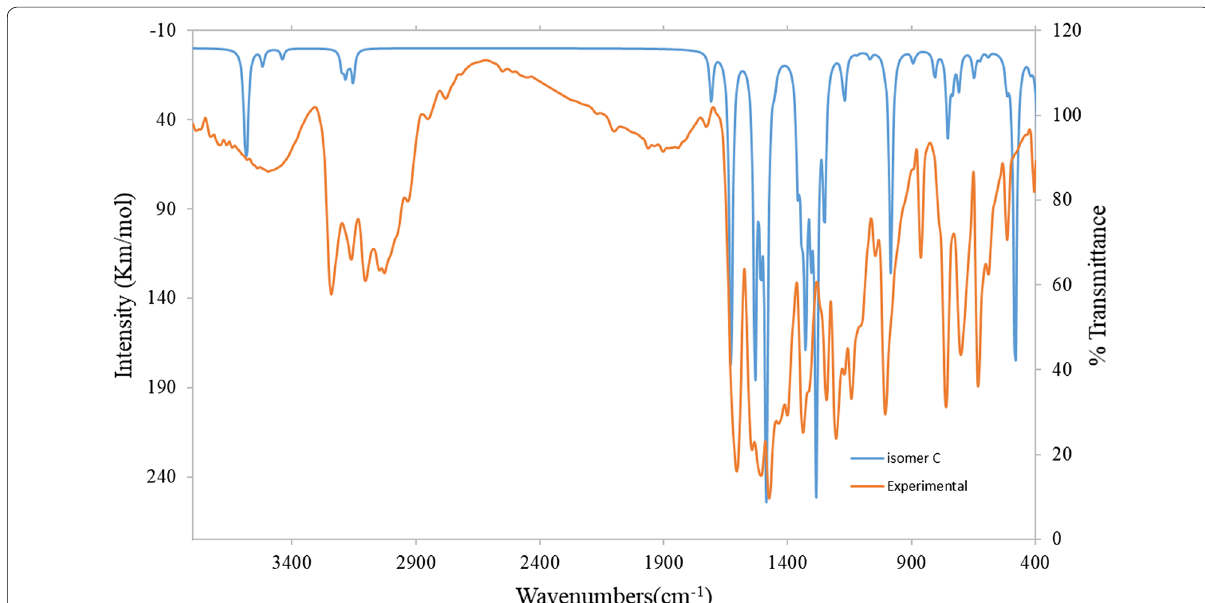
Fig. 9 Comparison of experimental and theoretical IR spectra of N ‑(pyridin‑2‑yl)hydrazinecarbothioamide